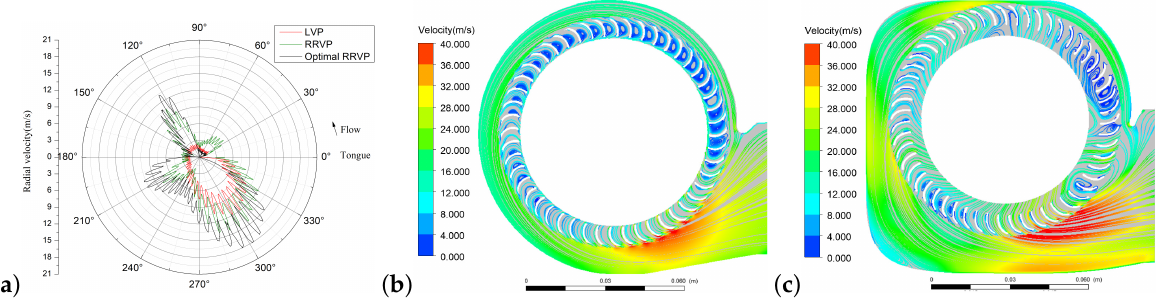
Figure 22. Comparison of impeller outlet radial velocity distribution and streamlines in section A: